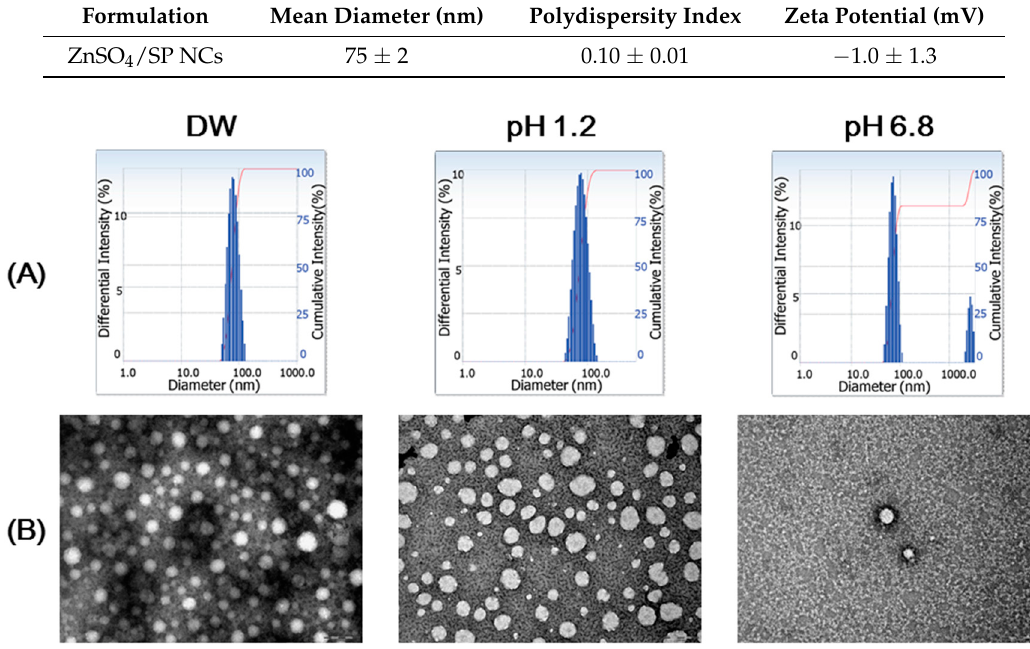
Table 1. Particle characterization of ZnSO 4 /SP NCs ( n ≥ 3).